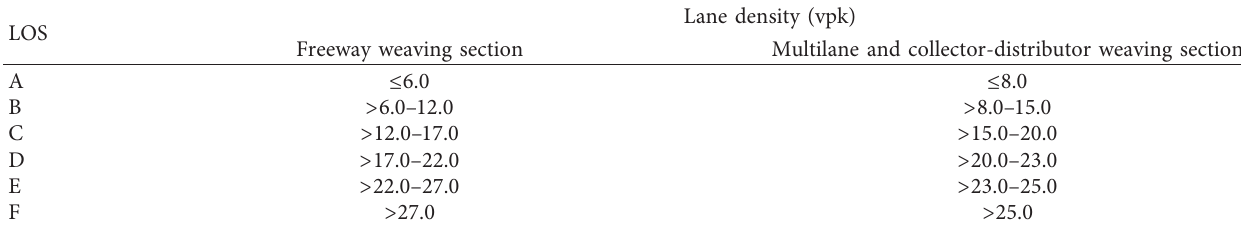
Table 2: Level of Service (LOS) criteria for weaving